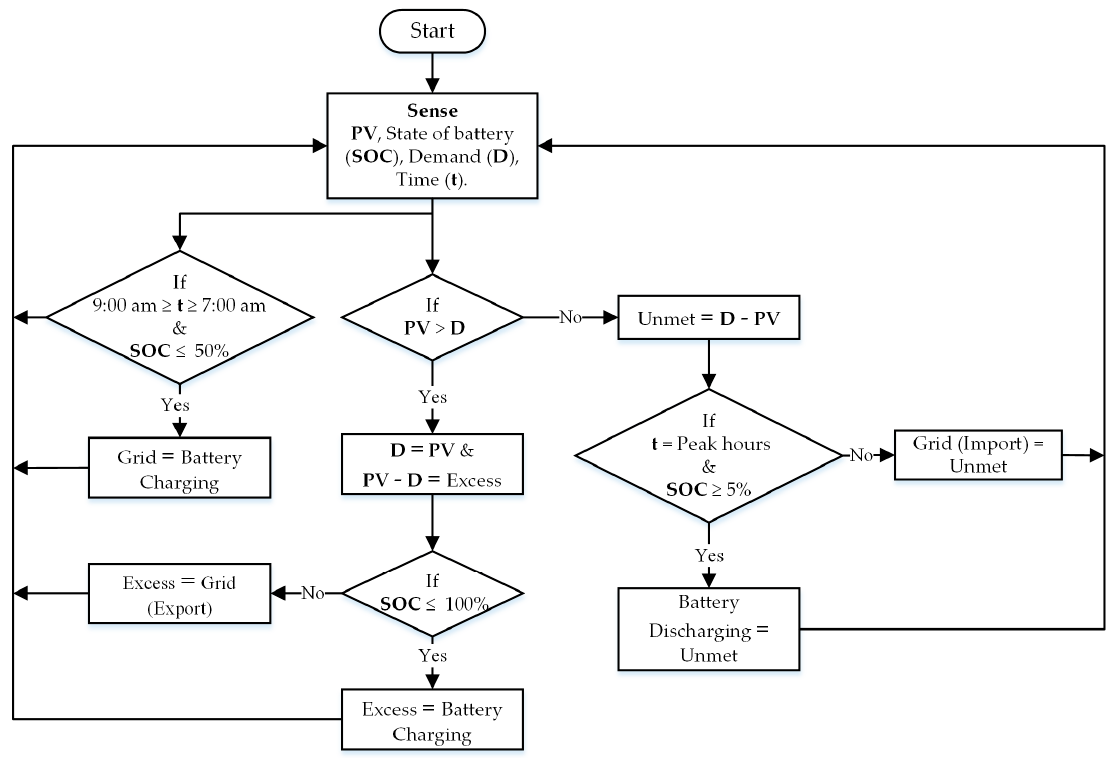
Figure 5. Flowchart of the hybrid PV and battery storage system (BSS) system. SOC, state of charge.